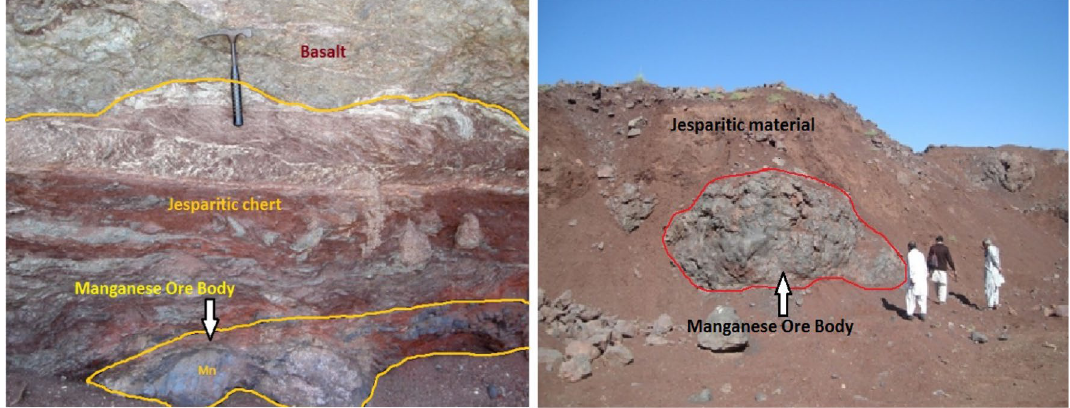
Fig. 3 Field photographs of exposed Mn ore bodies a manganese ore body in a vein form hosted by jesperitic chert. b Exposed Mn ore deposits ore in unconsolidated jesperitic material in the Bela